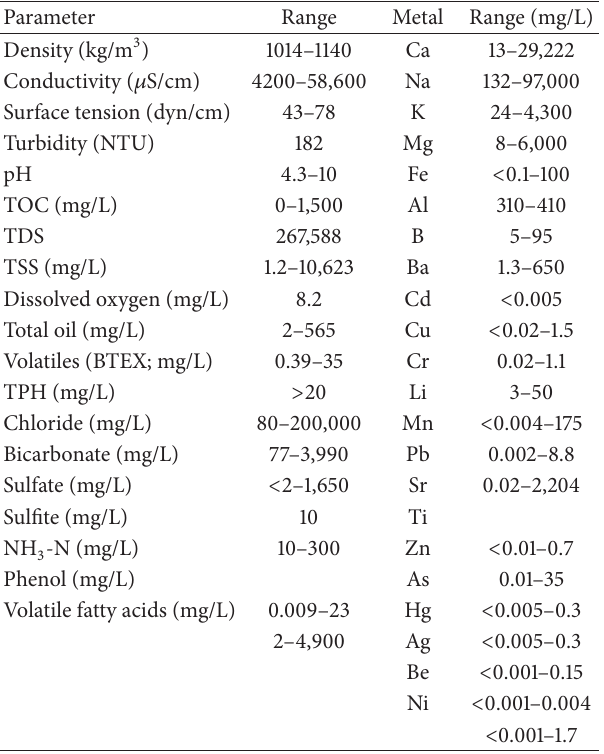
Table 3: Composition of oilfield produced